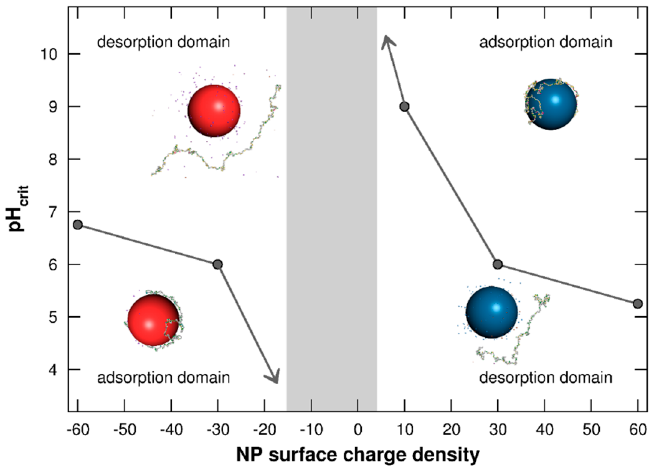
Figure 4. Adsorption/desorption limits pH crit of PP chain situated in the NP adsorption layer as a function of NP surface charge density ( σ = − 60 to +60 mC/m 2 ). Negative and positive NPs are represented by red and blue spheres. Monovalent counterions are present. The grey area shows the σ range in which no complex formation is observed.